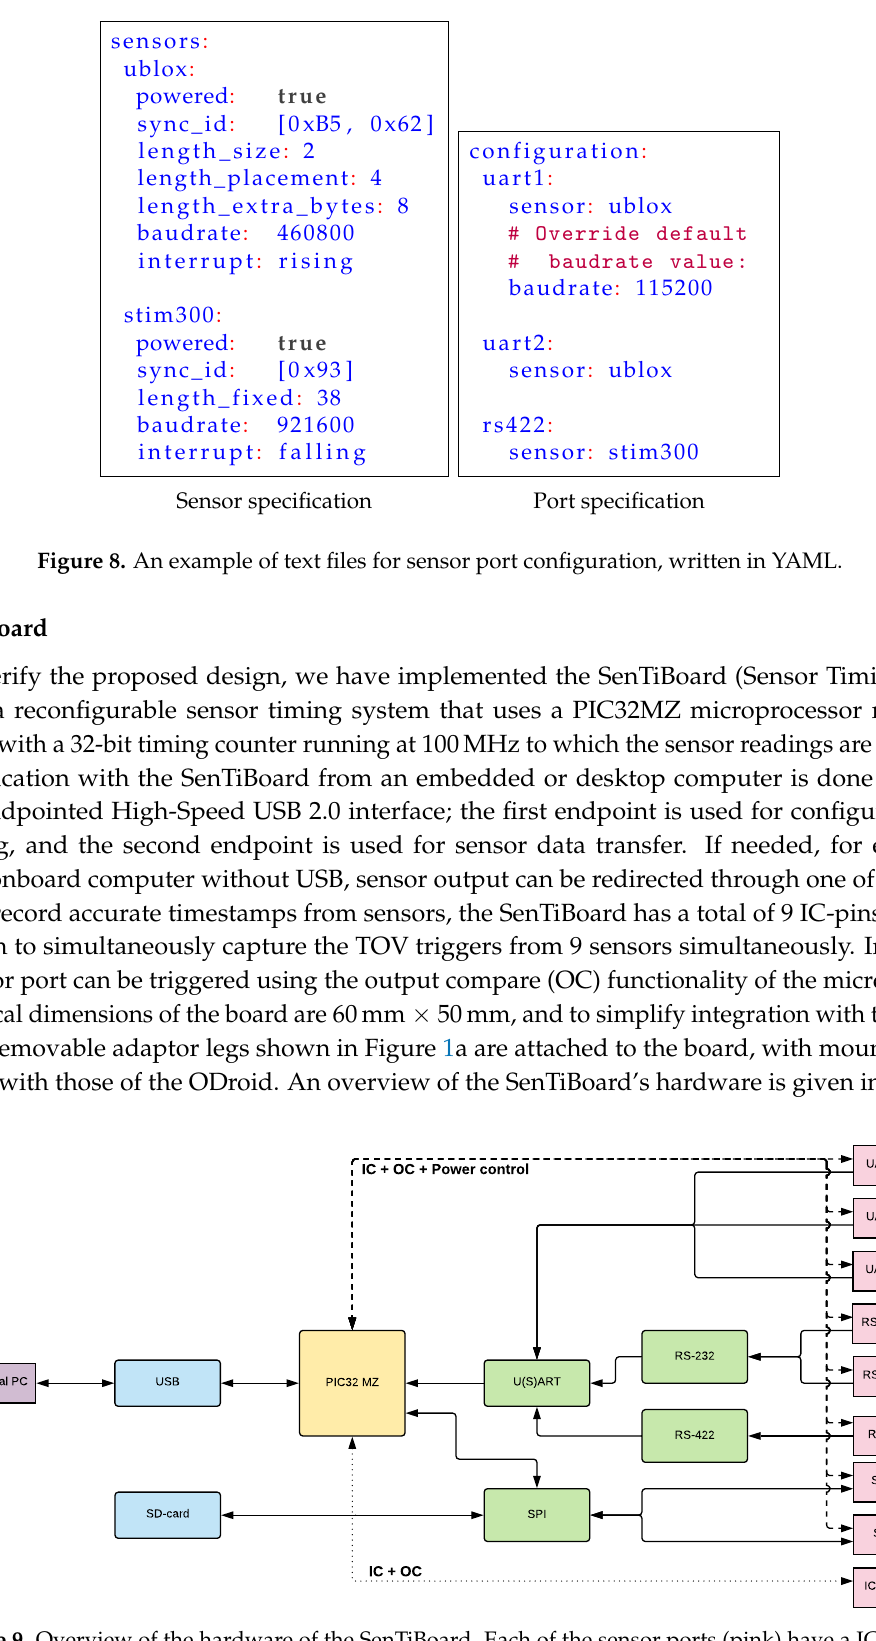
Figure 9. Overview of the hardware of the SenTiBoard. Each of the sensor ports (pink) have a IC-input pin, a OC-output pin and a power control pin in addition to pins for the associated protocol. The pink IC/Trig port only contains an IC-input pin and an OC-output